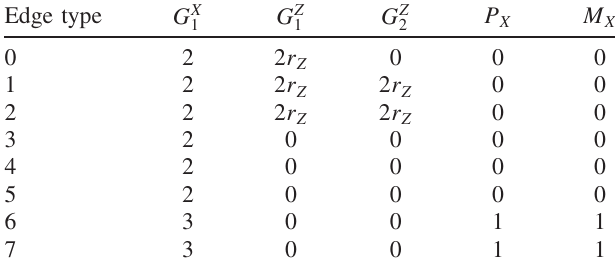
FIG. 11. The different types of edges in the 3D matching graph of the subsystem surface code for X -type checks only, when all X -type gauge operators are fixed. Each unique edge type is labeled with a number. If an asterisk is present in the label, the edge is from time step t to t þ 1 , otherwise, the edge is purely spacelike. The whole X matching graph for a single time step is drawn with gray dashed lines.